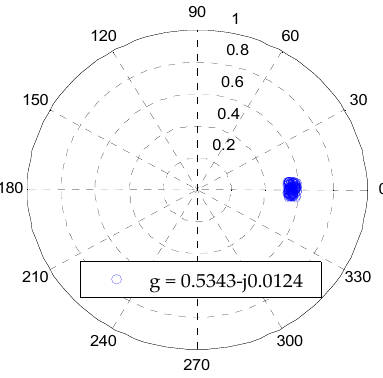
Figure 14. Results of the estimated g based on LSM (two broken points). Table 5. Estimation results of Z MGN_m and SC .